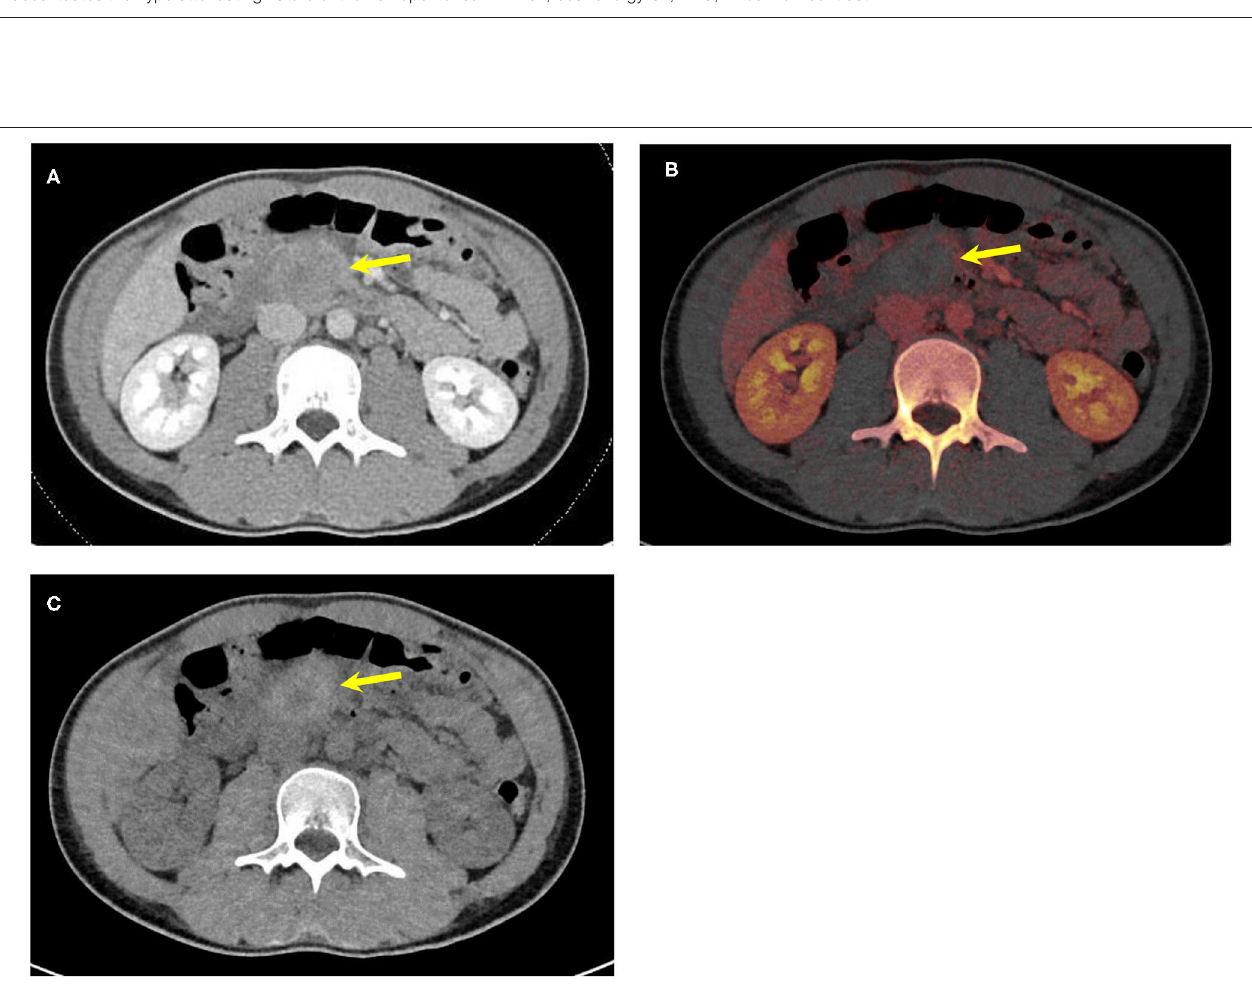
FIGURE 2 | An 18-year-old male patient—hockey stick injury. (A) Conventional mixed DECT image demonstrates duodenal wall hematoma (yellow arrow). (B) Iodine overlay images increase the conspicuity of the duodenal hematoma by differentiating enhancing bowel from a non-enhancing duodenal hematoma (yellow arrow). (C) DECT VNC accentuates the hyperattenuating nature of the duodenal hematoma (yellow arrow). DECT, dual-energy CT; VNC, virtual non-contrast.